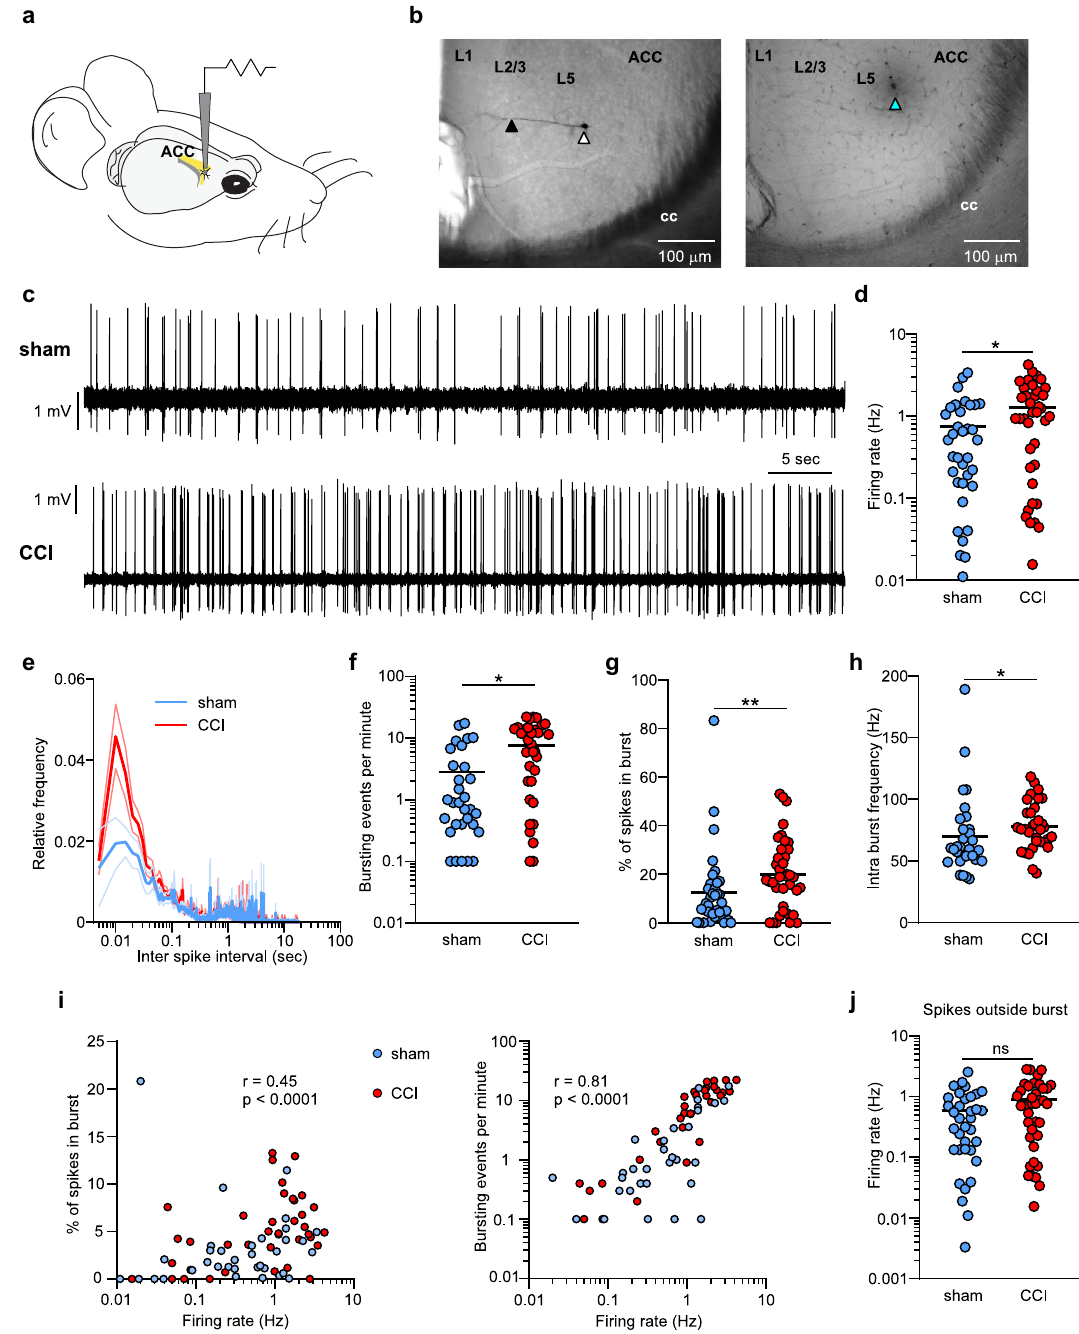
Figure 3. Increased spontaneous activity of deep layers vACC pyramidal neurons in mice with CCI of the sciatic nerve. (a) Schematic diagram showing in vivo electrophysiological recording of spontaneous activity in deep layers of vACC. (b) Representative microphotographs depicting recordings locations in vACC. Left: pyramidal neuron of layer 5 vACC labeled with biocytin during in vivo juxtacellular recording. Arrowheads indicate cell body (white) and apical dendrite (black). Right: pontamine sky blue spot deposited at the end of a recording session. The spot was used as a reference landmark to reconstruct recording locations of non-labelled cells. (c) Representative traces of one minute segments of spontaneous firing. Vertical deflections are single action potentials. (d) Enhanced spontaneous firing rate in neurons from CCI lesioned mice (CCI n = 38; Sham n = 35; * p < 0.05, Mann Whitney test). (e) Inter-spike histogram calculated from spontaneous activity. Thick and thin lines represent the mean and confidence interval (+ /- standard error), respectably. (f–h) Parameters related to bursting activity were increased in CCI mice (* p < 0.05, ** p < 0.01, Mann Whitney test). (i) For the overall population of neurons, bursting parameters were significantly correlated with spontaneous firing rate (Spearman correlation, N = 73). (j) Spontaneous firing rate outside burst was similar between neurons from sham and CCI lesioned mice (CCI n = 38; Sham n = 35; * p = 0.09, Mann Whitney